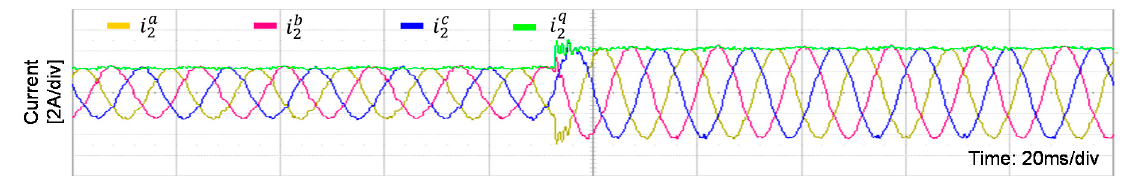
Figure 23. Experimental results for the proposed control method under the grid frequency change from 60 Hz to 50 Hz. ( a ) Three-phase grid currents under distorted grid; ( b ) three-phase grid cur- rents under distorted and imbalanced grid voltages with 𝑒 (cid:3028) drop to 83.33% of the nominal value.